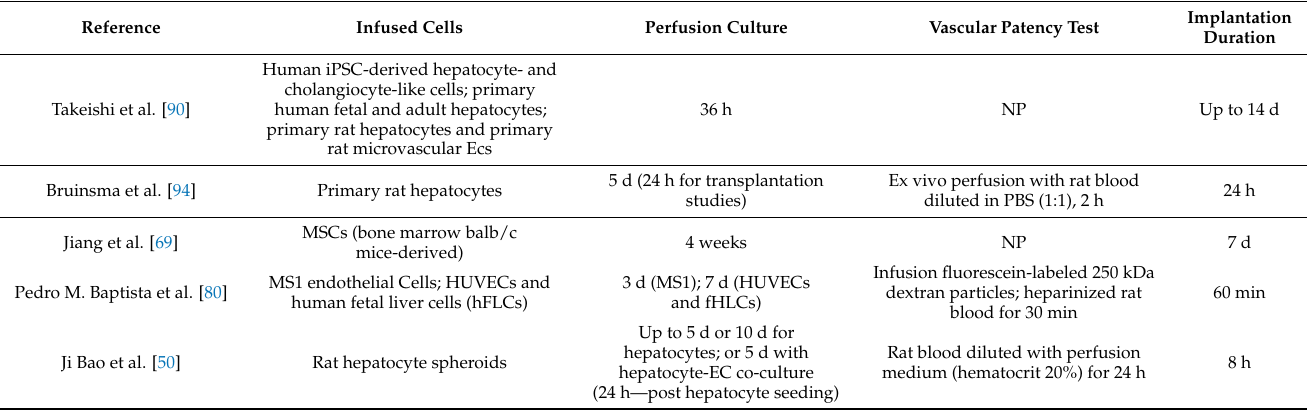
Table 1. Rodent models in transplantation